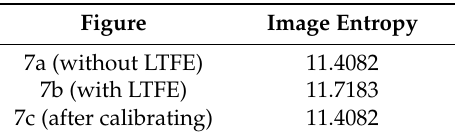
Table 8. Image contrast of Figure 7. Figure Image Contrast